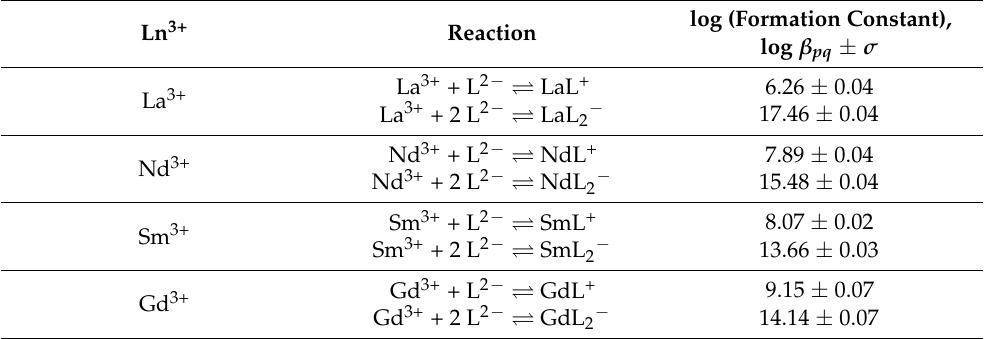
Table 3. Summary of Ln 3+ –harzianic acid (H 2 L) formation constants. σ denotes the estimated standard